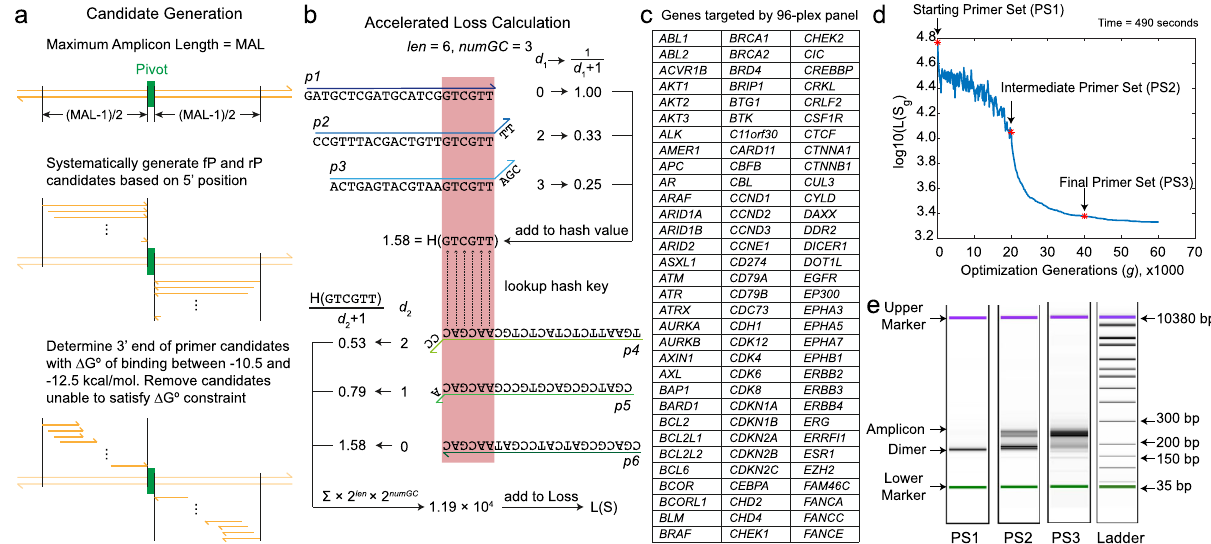
Fig. 2 Implementation and experimental evaluation of a multiplex primer design algorithm based on the SADDLE framework. a Method for generating candidate primer sequences for a DNA target T. b Implementation of Badness function that can be rapidly evaluated using hash tables. len is the length of the subsequence, numGC is the number of G/C nucleotides in the subsequence. d 1 and d 2 are the distances of the subsequence to the 3 ′ ends of primer p a and p b , respectively. p 1 , p 2 , p 3 are examples of primer p a , and p 4 , p 5 , p 6 are examples of primer p b . c List of cancer genes selected as target sequences for a 96-plex primer set design. See Supplementary Excel spreadsheet for target selection details. d Loss function of primer sets S( g ) across optimization generations g . The Loss function value decreases through the optimization and approaches a local minima after roughly 400 generations. We selected three different primer sets, constructed at generations 0, 200, and 400 for experimental evaluation; these are respectively called PS1, PS2, and PS3 for the remainder of this paper. Computation time for a 96-plex panel design is about 490 s for 60,000 iterations on a conventional laptop. e